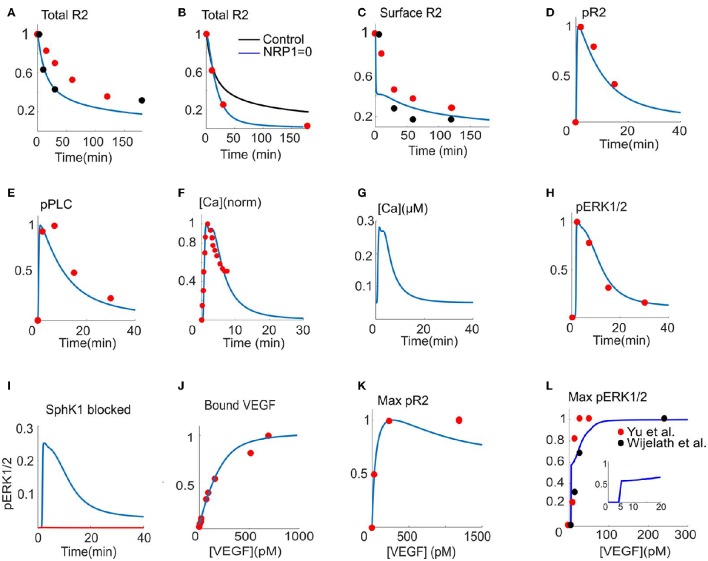
Model parameterization. (A) Total VEGFR2 (R2) computed as fraction total versus time fitted to two sets of experimental data from Bruns et al. (2010) and Ballmer-Hofer et al. (2011) (red and black circles), (B). R2 versus time with (blue) and without (black) NRP1 fitted to the data in Ballmer-Hofer et al. (2011) (red circles), (C). Surface level of VEGFR2 constrained with two sets of experimental data from Ewan et al. (2006) and Bruns et al. (2010) (red and black circles). (D) Fraction of phosphorylated receptors (pR2) is fitted to the experimental data in Chabot et al. (2009) (red circles). (E) Phosphorylated PLCγ from the model fitted to the data in Chabot et al. (2009) (red circles). (F) Normalized calcium transient from the model fitted to the normalized experimental data in Li et al. (2011) (red circles). (G) Raw calcium trace corresponding to the normalized transient in (F). (H) pERK1/2 fit to the data in Chabot et al. (2009) (red circles). (I) SphK1 inhibition abolishes pERK1/1 consistent with the data in Shu et al. (2002) (red versus blue curves). (J) Binding of VEGF to the binding sites on the cell surface versus VEGF concentration (Bikfalvi et al., 1991), (K). Dose response curve for pR2 is fitted to the experimental data in Whitaker et al. (2001) (red circles), (L). Dose response curve for the activation of ERK1/2 is fitted to two sets of data from Wijelath et al. (2006) and Yu et al. (2015) (red and black circles). The inset indicates sudden jump in pERK1/2 as VEGF in increased above threshold.